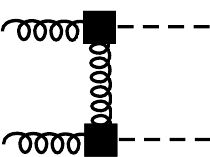
Figure 3. Higgs-pair production in gluon fusion at NLO: examples for virtual one-loop diagrams at order g 4 . s